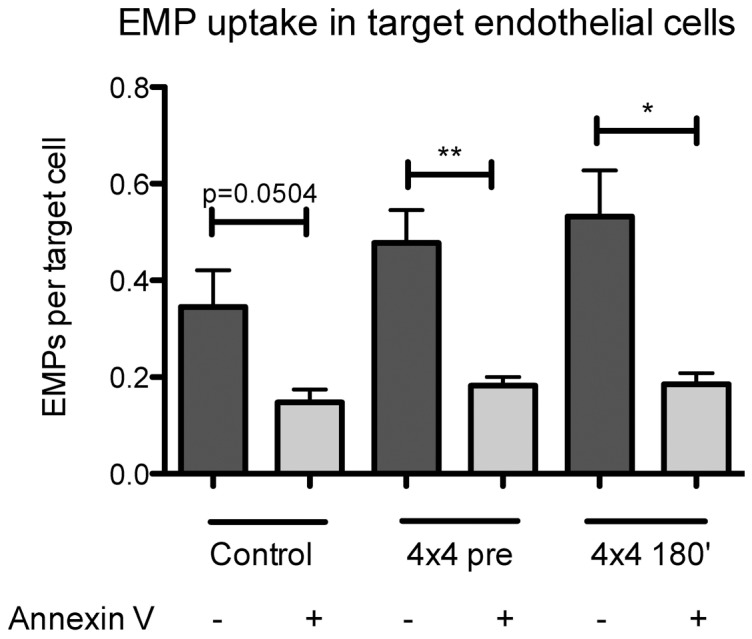
Annexin I prevents EMP uptake into target endothelial cells.HCAEC were stimulated with EMP and sera for 4(3 µg/mL) for 1 hour in the presence of CaCl2 (5 mmol/L final concentration). N = 5, * = p<0.5, ** = p<0.01.